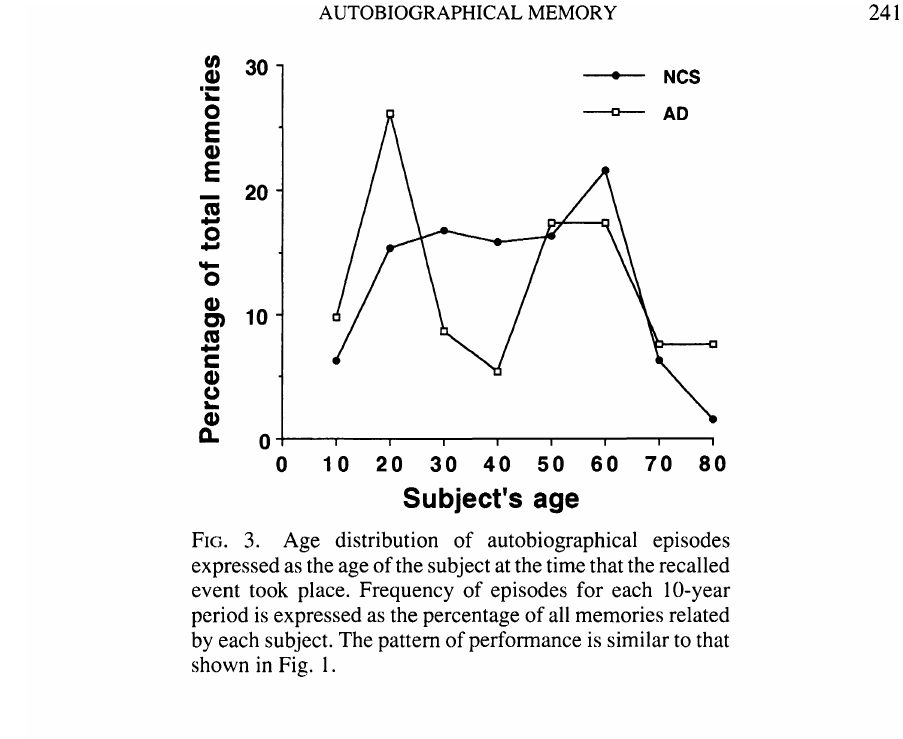
FIG. 3. Age distribution of autobiographical episodes expressed as the age of the subject at the time that the recalled event took place. Frequency of episodes for each lO-year period is expressed as the percentage of all memories related by each subject. The pattern of perfonnance is similar to that shown in Fig.